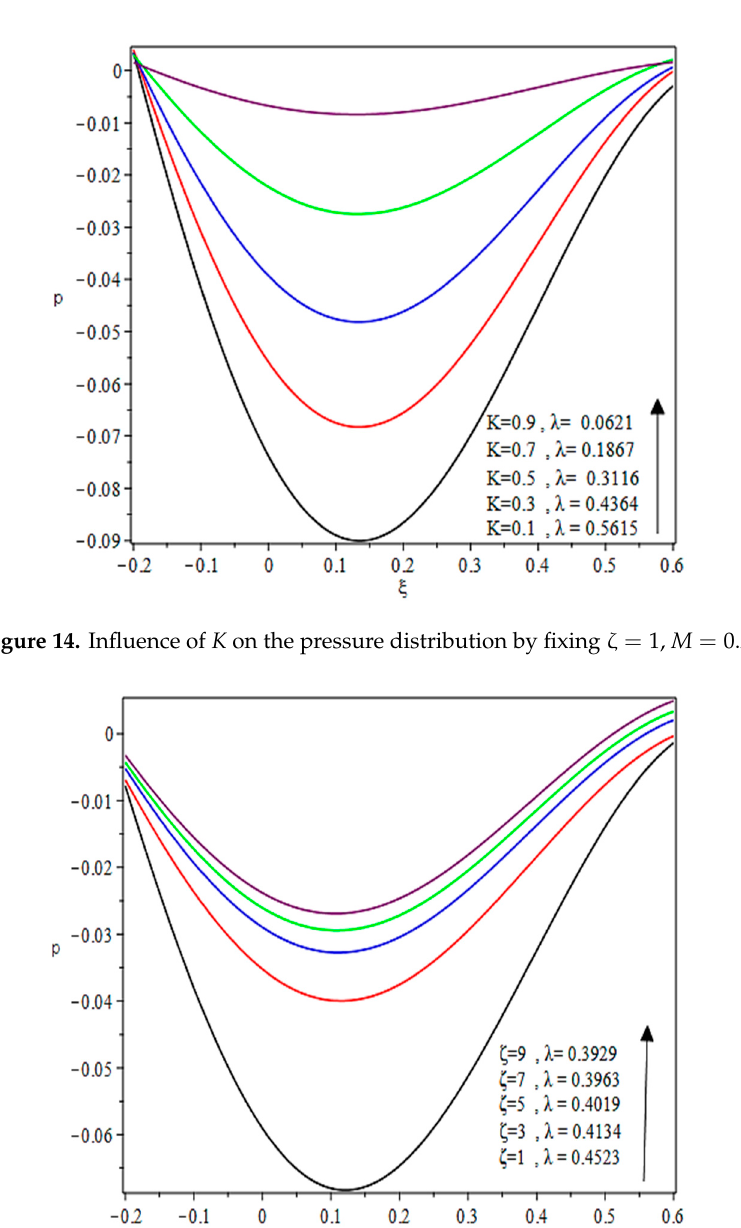
Figure 15. Viscoelastic parameter ζ influence on the pressure distribution by fixing K = 0.1, M = 1.